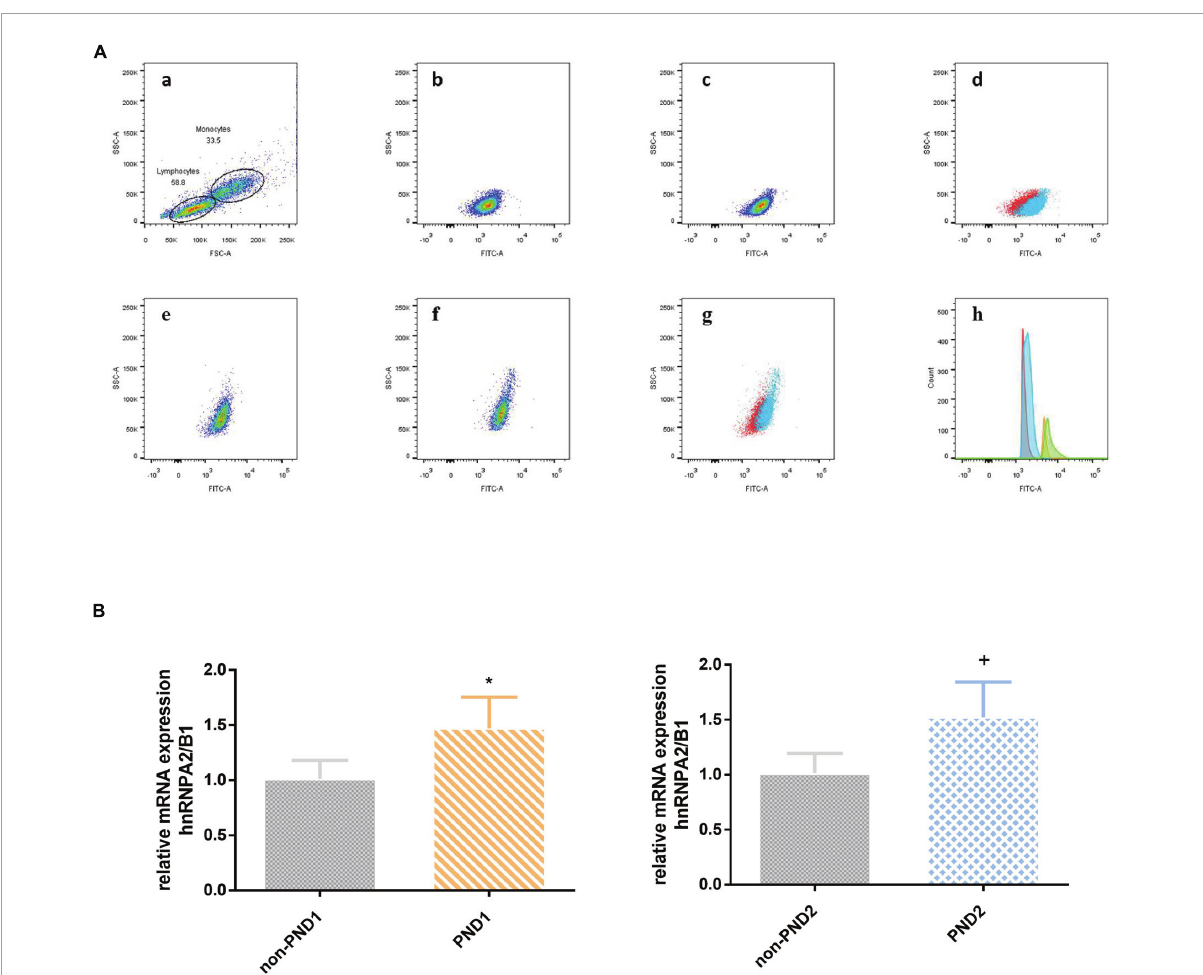
FIGURE2 (A) The expression of hnRNPA2/B1 in PBMC was analyzed by FCM. The effect regions were created for FSC and SSC (a) ; median fluorescence intensity of hnRNPA2/B1 in lymphocytes between PND and non-PND (b,c) , and the overlay of two groups ( d ; PND, blue; non-PND, red); median fluorescence intensity of hnRNPA2/B1 in monocytes between PND and non-PND (e,f) , and the overlay of two groups ( G ; PND, blue; non-PND, red); histogram overlay of hnRNP A2/B1 expression in patients with PND compared to patients without PND in different cell population ( h ; lymphocytes of non-PND, red; lymphocytes of PND, blue; monocytes of non-PND, orange; monocytes of PND, green). (B) mRNA level analysis of hnRNPA2/B1 in PBMCs. Data are expressed as the mean ± SD. Note that mRNA expression of hnRNPA2/B1 in patients with PND significantly increased compared with those without PND. * p < 0.05 compared with group Non-PND 1 . + p < 0.05 compared with group Non-PND 2